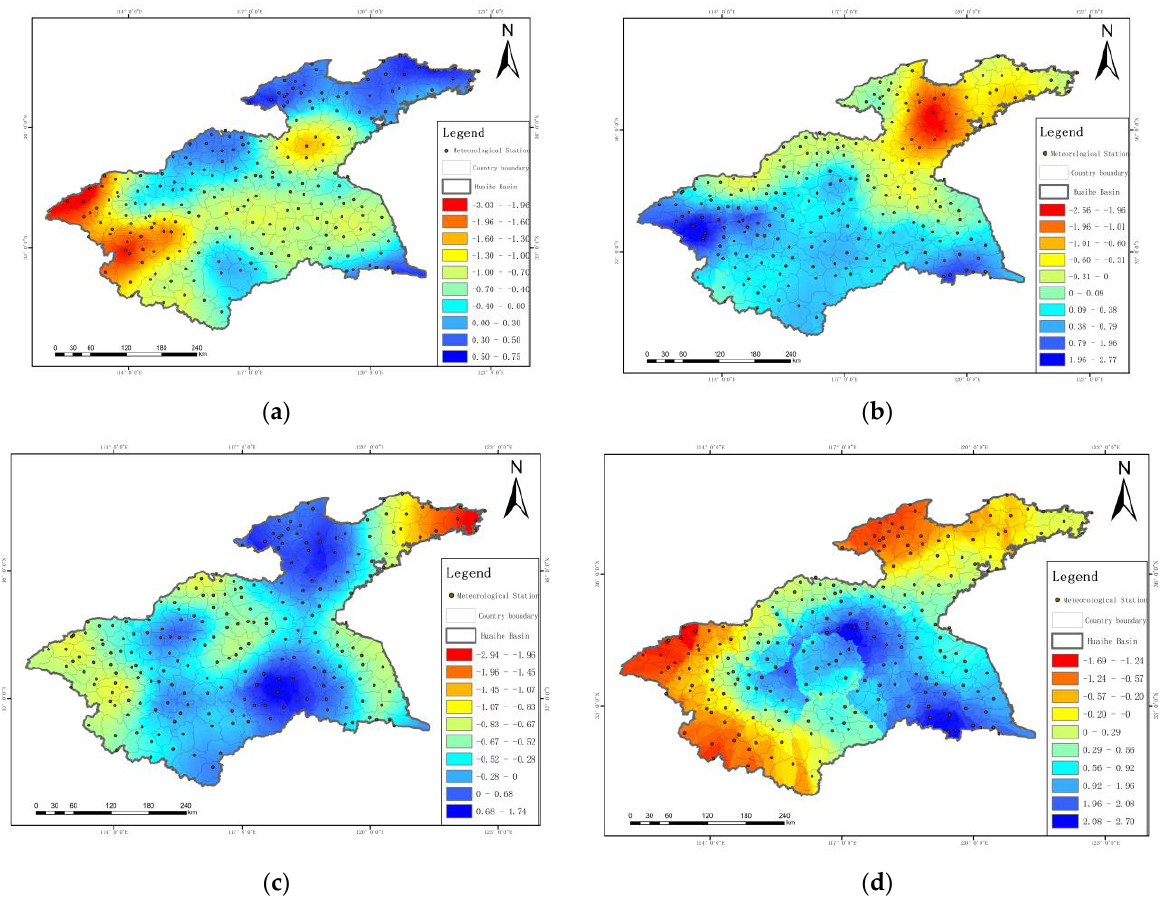
Figure 6. Spatial distribution of precipitation Z-values in different seasons. ( a ) Spring, ( b ) Summer, ( c ) Autumn and ( d ) Winter.